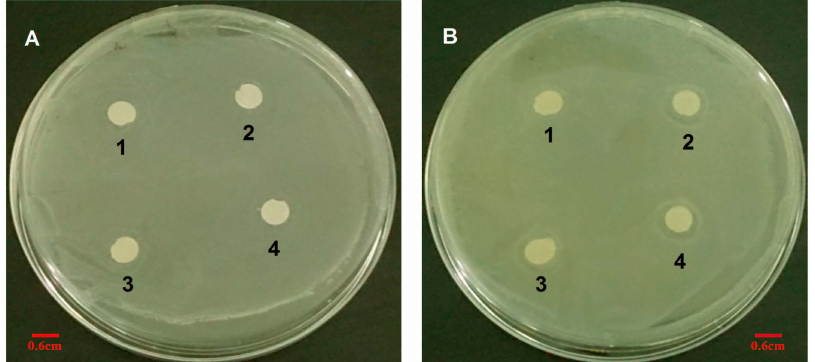
Figure 13. Diameter of inhibition zone test of ( A ) VCM solution and ( B ) VCM/TMC nanoparticles against S. aureus . (1). 50 µ g/mL; (2). 60 µ g/mL; (3). 70 µ g/mL; and (4). 80 µ g/mL in the LB agar